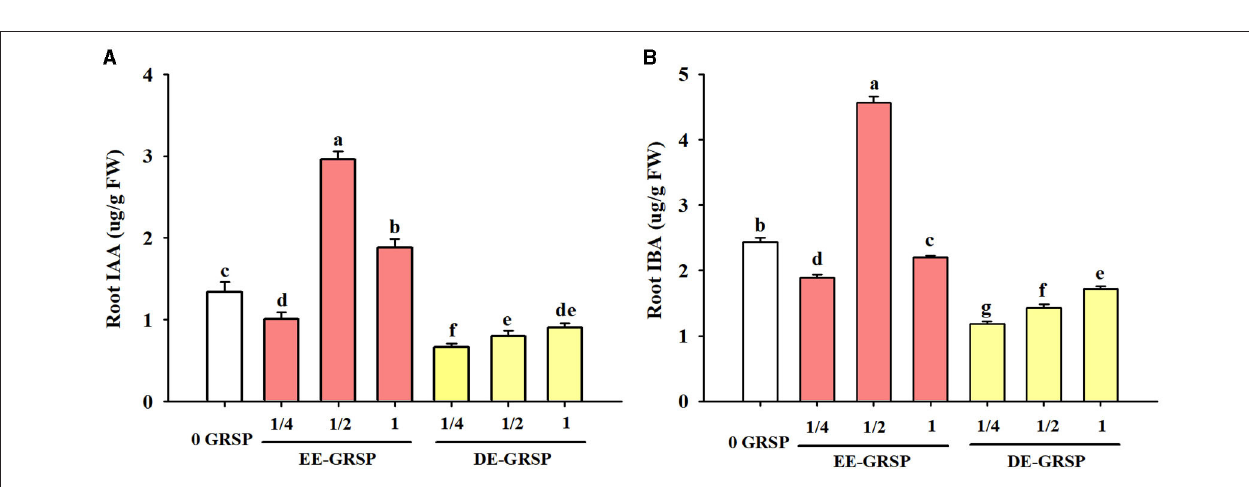
FIGURE 6 | Effects of exogenous EE-GRSP and DE-GRSP on root IAA (A) and IBA (B) concentrations of trifoliate orange seedlings. Data (mean ± SD, n = 4) followed by different letters above the bars indicate significant differences ( p < 0.05). DE-GRSP, difficultly extractable glomalin-related soil protein; EE-GRSP, easily extractable glomalin-related soil protein; IAA, indoleacetic acid; IBA, indolebutyric